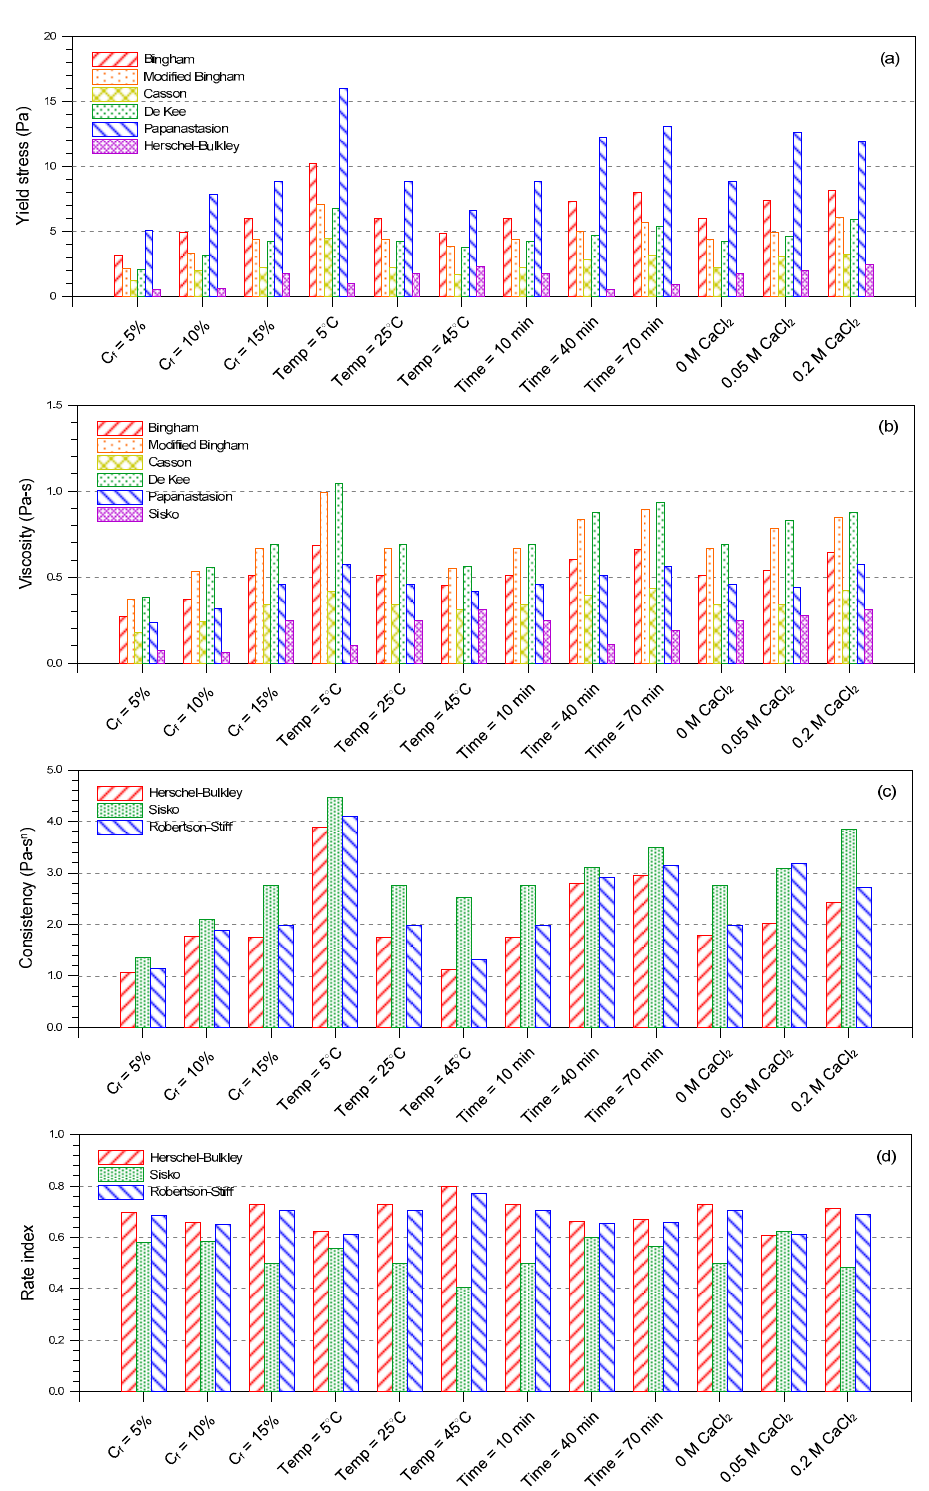
Figure 4. Rheological properties estimated by prediction models for fly ash mixed with tailings slurries: ( a ) yield stress; ( b ) viscosity; ( c ) consistency; ( d ) rate index.